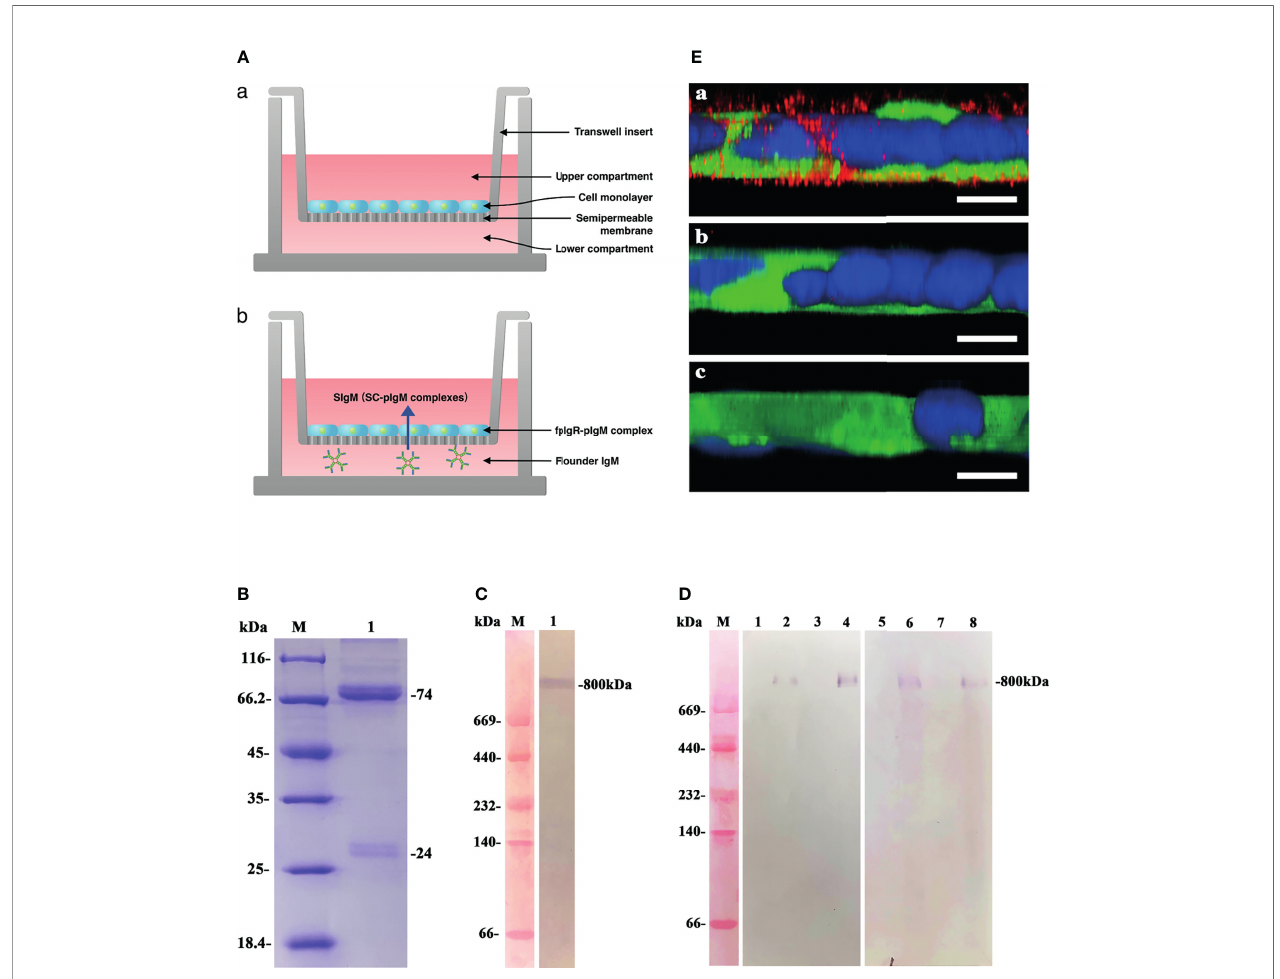
FIGURE 8 | Functional evaluation of polarized MDCK-fpIgR monolayer cells to transport polymeric IgM. (A) Schematics of in-vitro Transwell assay for transcytosis of pIgM by the fpIgR. (a) Polarized MDCK-fpIgR cell monolayers grown on Transwell fi lters; (b) transepithelial transport of pIgM mediated by fpIgR across MDCK-fpIgR cells. (B) The denaturing electrophoresis result of serum IgM of fl ounders. Lane M: Protein molecular weight standards (kDa); lane 1: serum IgM collected. (C) Western blotting under native denaturing electrophoresis. Lane M: Protein molecular weight standards (kDa); lane 1: puri fi ed serum IgM at ~800 kDa. (D) Western blotting of IgM transported by polarized monolayer cells. Lane M: Protein molecular weight standards (kDa); lanes 1 – 4: samples reacted with anti-serum IgM MAb 2D8. Lanes 5 – 8: samples reacted with mouse anti- fpIgR polyclonal antibody. IgM transported in MDCK-mock cell lines for 1 h (lanes 1 and 5) and 2 h (lanes 3 and 7) and in MDCK-fpIgR cell lines for 1 h (lanes 2 and 6) and 2 h (lanes 4 and 8), respectively. (E) CLSM images of IgM transported in a 3D MDCK-fpIgR transcytosis cell model in z -axis. (a) MDCK-fpIgR cells incubated with anti-serum IgM MAb 2D8. (b) MDCK-fpIgR cells incubated with non-immune mouse serum. (c) MDCK-mock cells incubated with anti-serum IgM MAb 2D8. Bar = 50